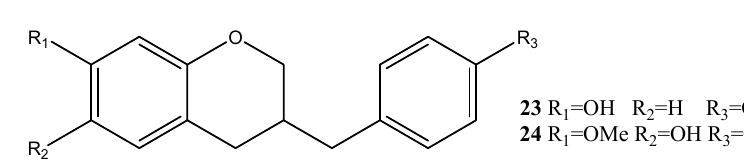
Figure 5. Structures of chromogen